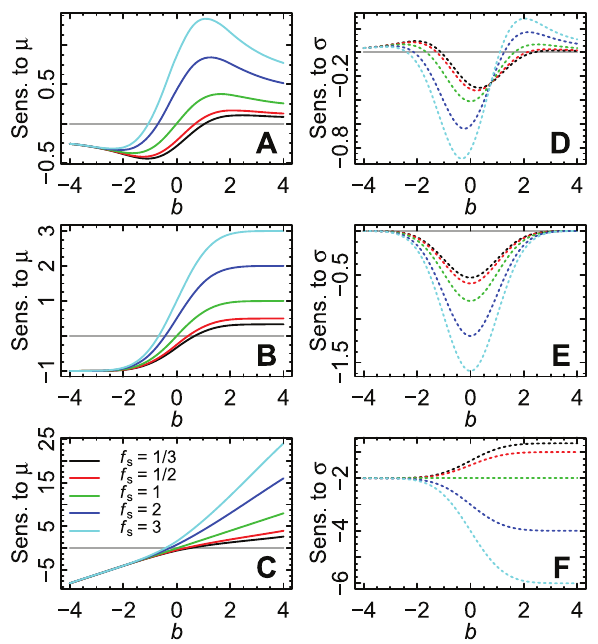
Figure 2. Comparison of signs of sensitivities. The sensitivities L ln l s = L m (A–C) and L ln l s = L s (D–F) are displayed; they were calculated numerically (Sections S3 and S4 in File S1). For b w 0 , the slope of the response function at the mean value of the local environment is positive (e.g., Figure 1B), and for b v 0 , the slope is negative; therefore the sensitivity to changes in m is largely of the same sign as that of the slope of the response function, as expected (A–C). The message here is that shifts of the mean environment toward the location of the peak of the response function usually cause an increase in ln l s , as expected, except possibly for some mean environments close to the peak. For a § 1 , sensitivity to changes in s is always negative (E–F); for a v 1 , sensitivity to changes in s can be positive (D). The message here parallels prior work: for a log-concave response function ( a § 1 ), increased environmental variance always reduces the long-term stochastic growth rate; but for a v 1 , the reverse can be true (see main text). Sensitivities did not depend on c . Signs of all sensitivities are identical to those displayed here for other values of a 2 because changing a 2 only rescales the vertical axes of all panels (Sections S3 and S4 in File S1). Here, a 2 ~{ 1 , and a ~ 1 = 2 (A, D), a ~ 1 (B, E), or a ~ 2 (C, F).